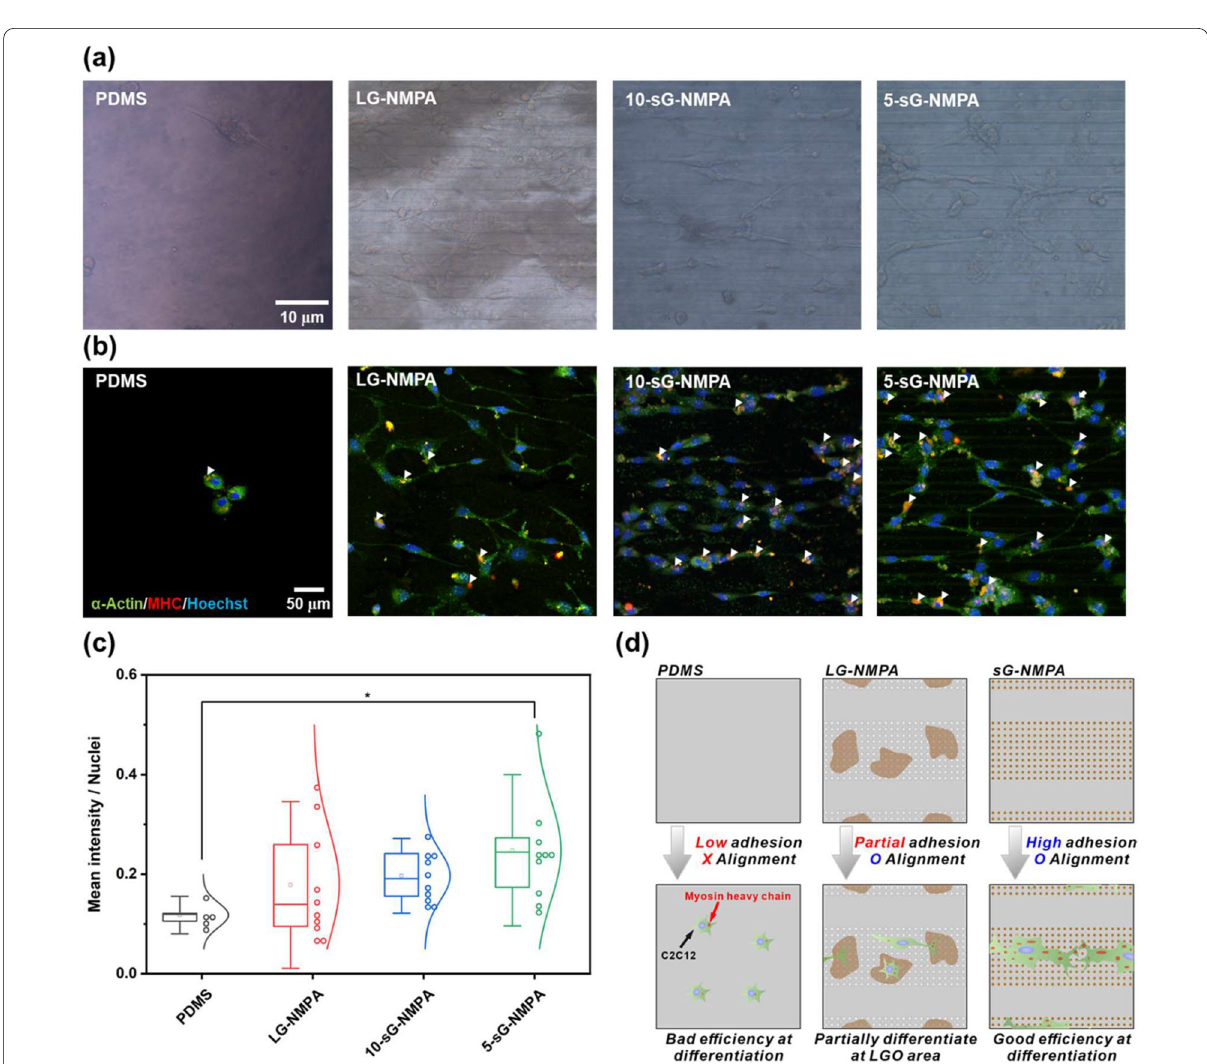
Fig. 5 Confirmation of myogenic differentiation of the cells. a Brightfield images of the cells on the bare PDMS, LG‑NMPA, 10‑sG‑NMPA, and 5‑sGO‑NMPA. b Confocal microscope images of the cells on bare PDMS, LG‑NMPA, 10‑sG‑NMPA, and 5‑sGO‑NMPA immunostained with α‑actin (Green), MHC (Red), and Hoechst (Blue). c The graph for mean intensity divided by number of nuclei. d Schematic diagram of the correlation between GO size and cell differentiation based on the mean intensity data. (* p ≤